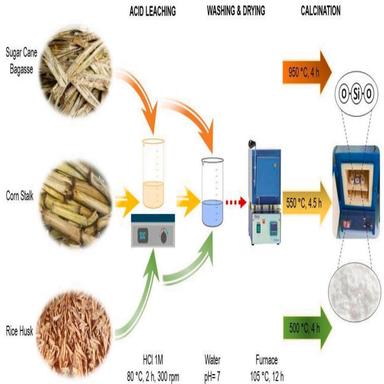
Schematic diagram of the processes for obtaining silica based on SCB, CS, and RH.